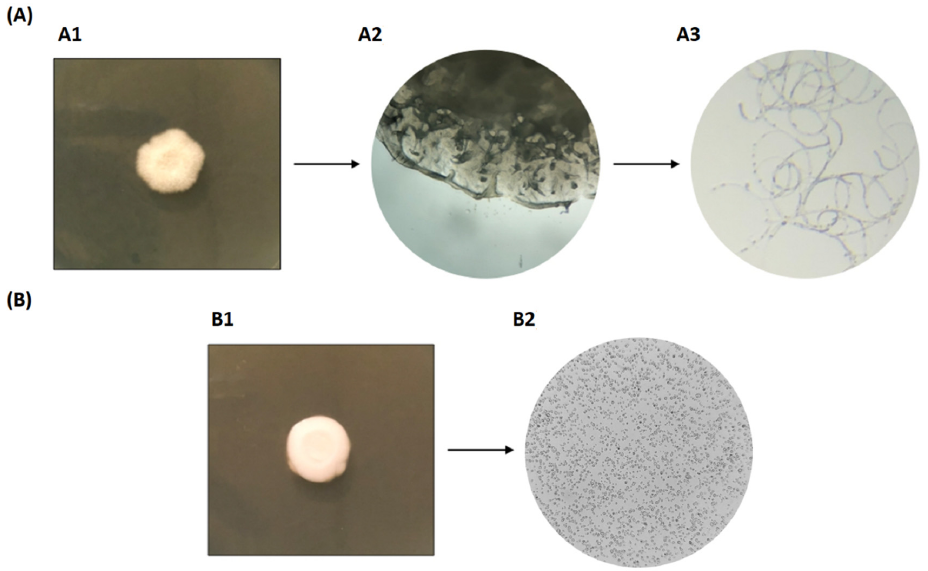
Figure 3. Representative images of the action of volatile compounds produced by the LRC1 strain against C. albicans . ( A ) C. albicans after incubation together with LRC1, as described in Section 2.6. ( A1 ): Image of a colony, ( A2 ): microscopic image of the structure of the colony (40× magnification), ( A3 ): microscopic image of a scraped sample of the C. albicans colony structure (40× magnification). ( B ) Control without D. hansenii yeast. ( B1 ): Image of a colony, ( B2 ): microscopic image of cells in the colony (40× magnification).